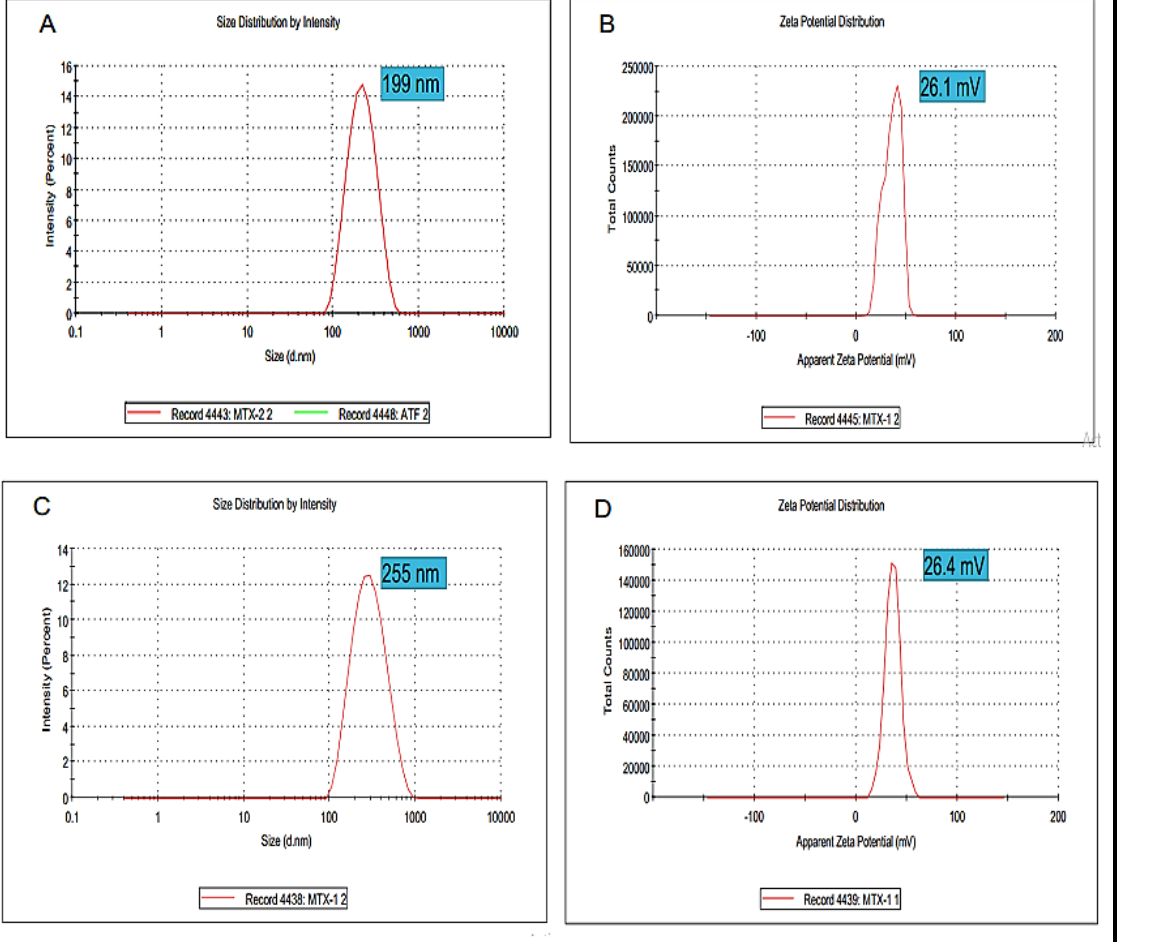
Figure 3. ( A ) & ( B ) showing particle size, zeta potential and PDI of blank NPs while ( C ) & ( D ) showing particle, zeta Figure 3. ( A , B ) showing particle size, zeta potential and PDI of blank NPs while ( C , D ) showing particle, zeta potential and potential and PDI of MTX - NPs. PDI of